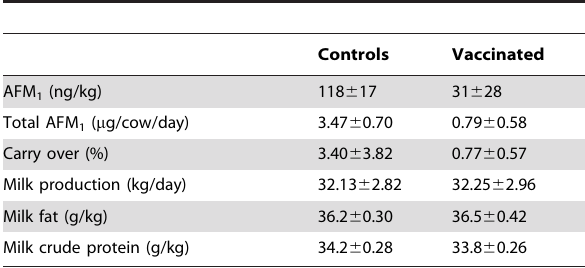
Table 4. Average concentration of AFM 1 , total excretion of AFM 1 , carry over rate, and milk production